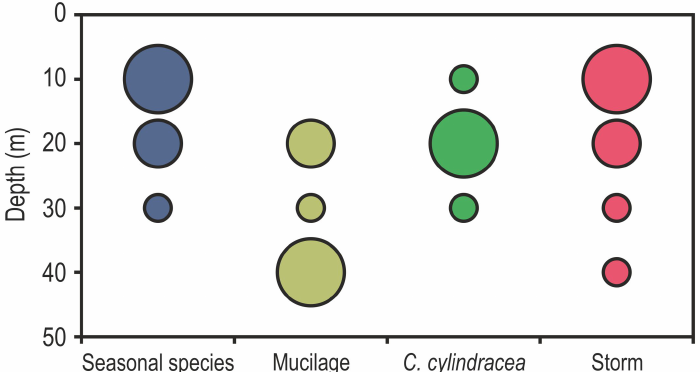
Figure 9. A schematic illustration of the level of pressure exerted by affectors considered (seasonality, mucilage, Caulerpa cylindracea , and the storm of 29 October) on the rocky reefs of Portofino MPA at the four depths investigated (circle sizes are roughly proportional to their